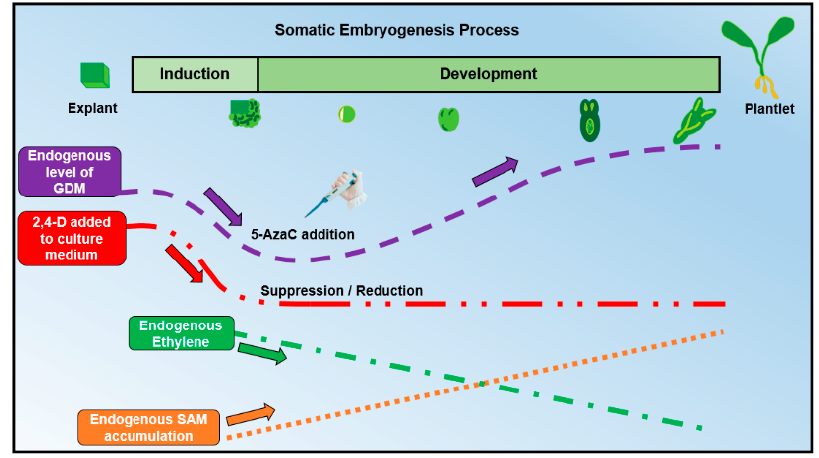
Figure 4. Global DNA methylation, SAM and ethylene dynamics when 2,4-D and 5-AzaC are added to the culture media during the SE process. SAM: S-adenosylmethionine. 2,4-D: 2,4-Dichlophenoxyacetic acid. GDM: global DNA methylation. The purple arrow represents the dynamics of GDM. The red arrow represents the amount of 2,4-D added into the culture medium. The green arrow represents the decrease in endogenous ethylene reported in different studies. The orange arrow represents the increase in the accumulation of endogenous SAM reported in different studies.